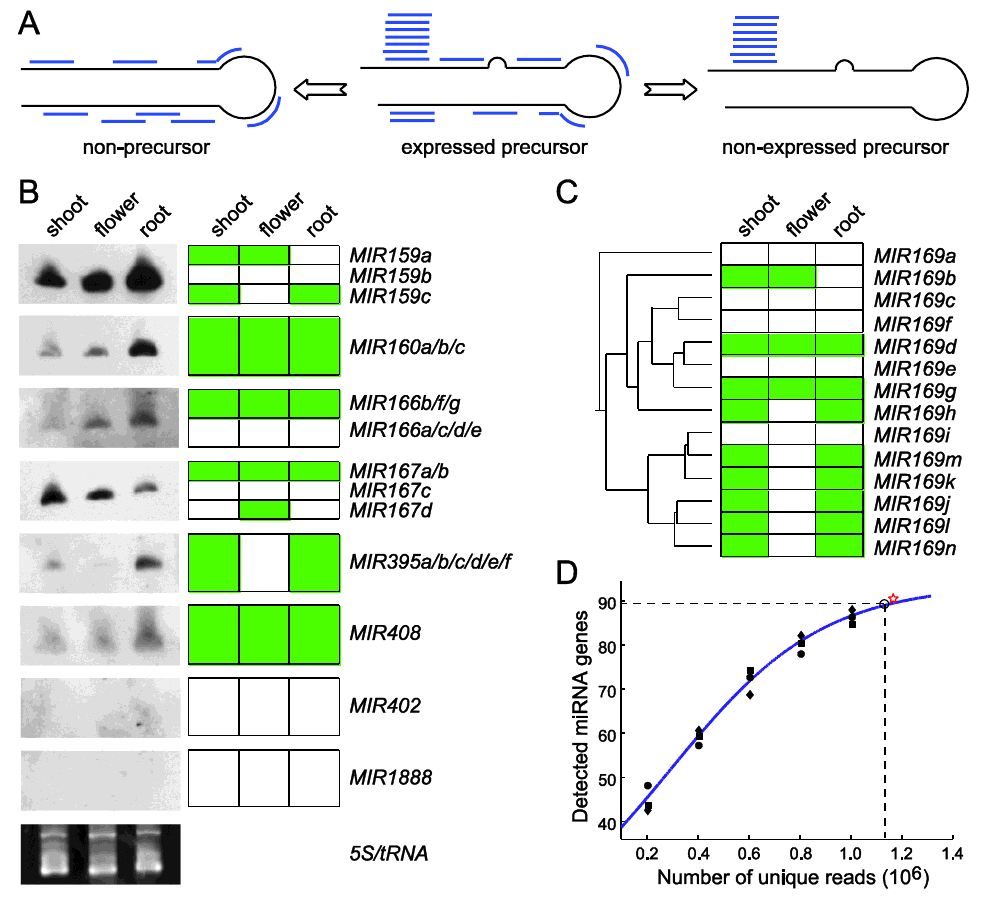
Figure 3. Using miRDeep-P to identify and profile miRNAs from deep sequencing data. ( A ) The core algorithm is based on a miRNA biogenesis model in which the small RNAs derived from a pre-miRNA are considered to have certain probabilities of being sequenced [41]. This model distinguishes an expressed pre-miRNA from a non-expressed pre-miRNA or a genomic locus with the potential to form a hairpin but is not processed by Dicer. ( B ) Validation of miRDeep-P results in Arabidopsis by Northern blotting. RNA blots are shown on the left. Ethidium bromide staining of the 5S/tRNA is used as a loading control. The expression pattern (represented by the green color) of individual genes deduced from the sequencing data is shown on the right with genes with identical pattern combined. ( C ) Relating miRNA expression to pre-miRNA phylogeny. The annotated pre-miRNAs of the miR169 family in Arabidopsis were used to construct a phylogenetic tree. The gene-level expression profile of family members is depicted to the right of the tree. ( D ) Simulation of the relation between miRNA detection rate and sequencing depth in Arabidopsis. Perfectly mapped unique reads from the shoot library were randomly retrieved to create five different simulated sequencing depths. The number of expressed miRNAs was determined at each depth. The scatter plot represents results from three independent simulations and was used for curve fitting. The star sign indicates the actual data from the shoot library. Dashed lines indicate a 95% detection rate of the theoretic maximal number of expressed miRNAs and the corresponding sequencing depth. Adapted from Yang et al.